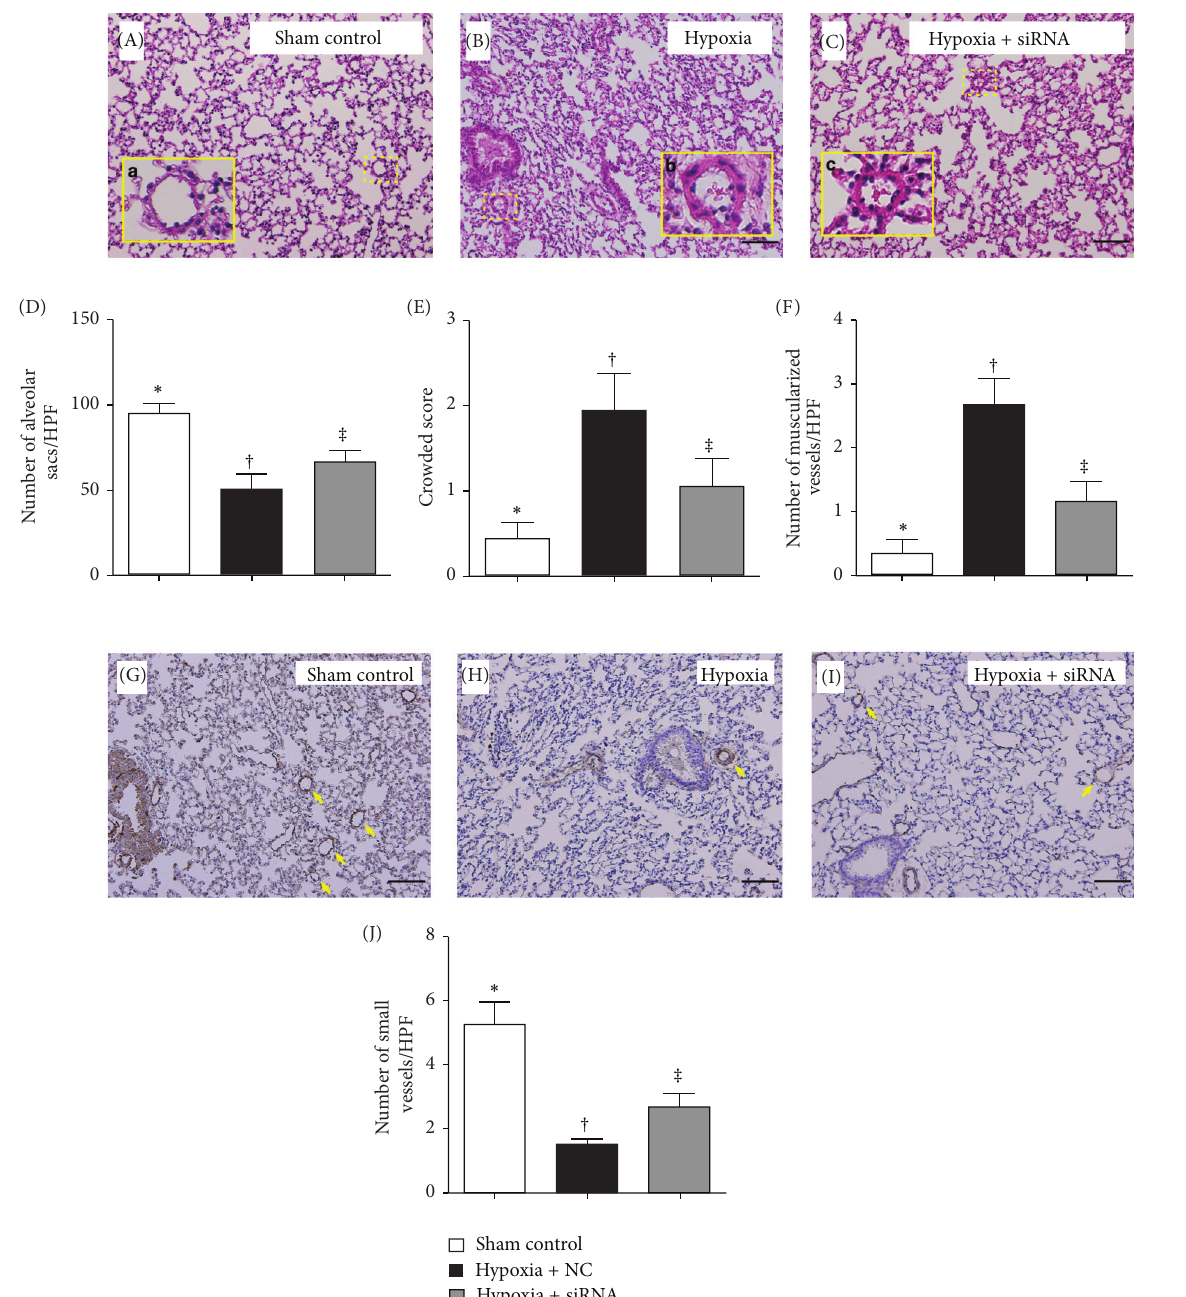
Figure 2: Histopathological and immunohistochemical (IHC) changes in lung parenchyma by day 28 after hypoxia-induced pulmonary arterial hypertension (PAH) ( 𝑛 = 10 ). ((A) to (C)) Hematoxylin and eosin (H & E) staining (100x) showing (A) normal pulmonary arterioles in sham controls, (B) hypertrophic muscularized medial layer of pulmonary arterioles (PA) in hypoxia-treated mice (i.e., dotted-squares magnified as solid-line squares), and (C) PA in hypoxia-treated animals with siRNA treatment. The scale bars in right lower corners represent 100 𝜇 m. (D) Number of alveolar sacs among the three groups. ∗ versus other groups with different symbols ( ∗ , † , ‡ ), 𝑃 < 0.0001 . (E) Crowded score of pulmonary tissue among the three groups. ∗ versus other groups with different symbols ( ∗ , † , ‡ ), 𝑃 < 0.001 . (F) Number of muscularized vessels per high-power field (HPF). ∗ versus other groups with different symbols ( ∗ , † , ‡ ), 𝑃 < 0.001 . ((G) to (I)) IHC staining (i.e., 𝛼 -SMA staining) (100x) illustrating the number of small pulmonary vessels (yellow arrows) among the three groups. (J) ∗ versus other groups with different symbols ( ∗ , † , ‡ ), 𝑃 < 0.001 . The scale bars in right lower corners represent 100 𝜇 m. HPF = high-power field. Statistical analysis in (D), (E), (F), and (J) using one-way ANOVA, followed by Bonferroni multiple comparison post hoc test. Symbols ( ∗ , † , ‡ ) indicate significance (at 0.05